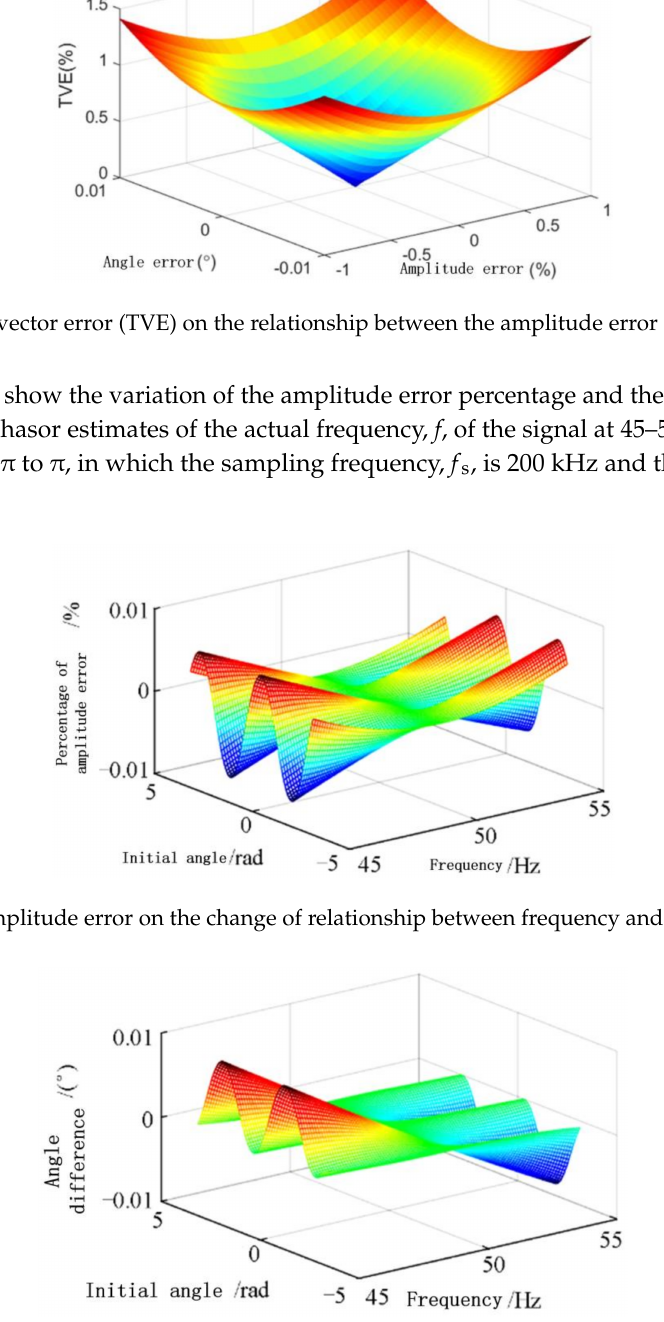
Figure 5. Angle error on the change of the relationship between frequency and initial